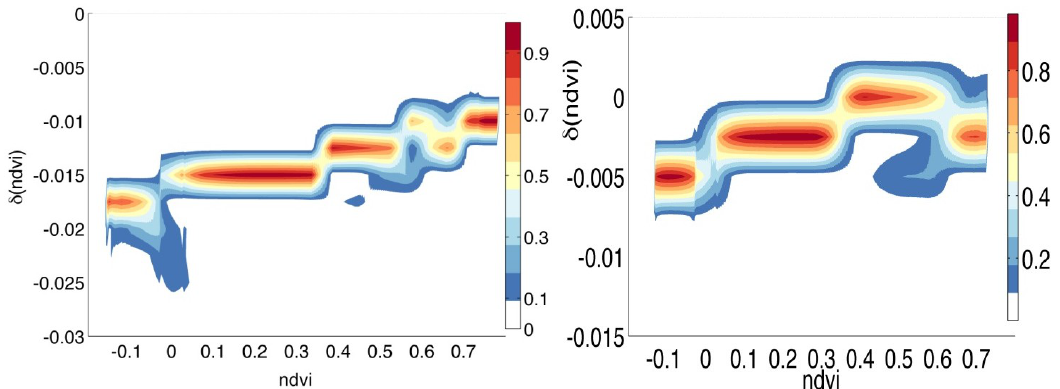
Figure A5. NDVI error budget is disaggregated by NDVI values for simulated NOAA-14 ( left ) and NOAA-16 ( right ). The error budget ranges from −0.025 in the low NDVI values (high-gain mode in channel-2) to -0.01 in the high NDVI values. The channel-2 slope discrepancy in Figure A2 might account for this